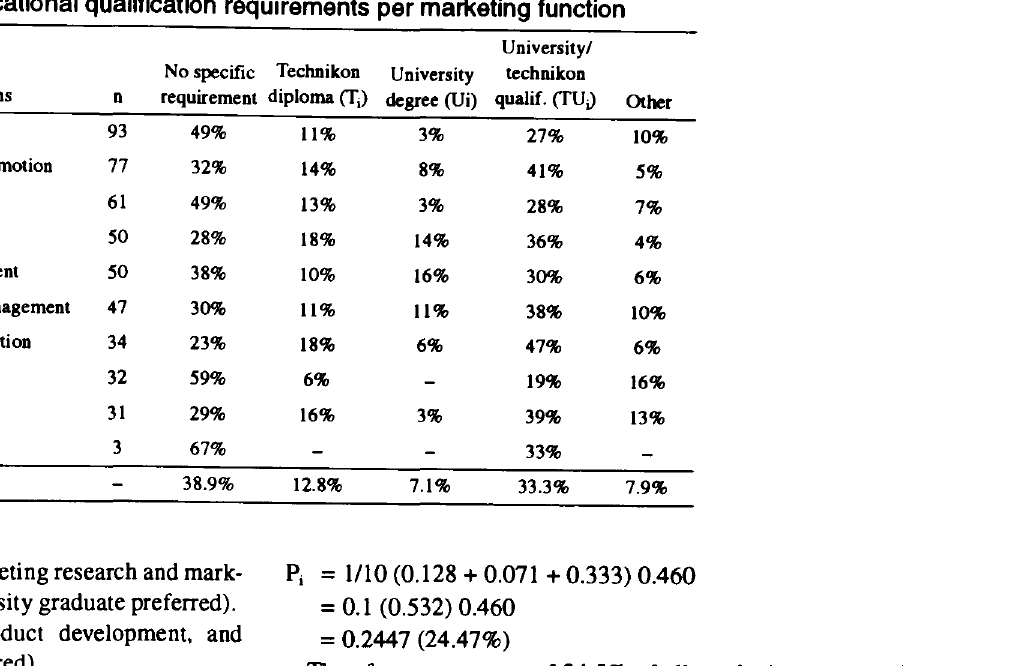
Table 5 Educational qualification requirements per marketing